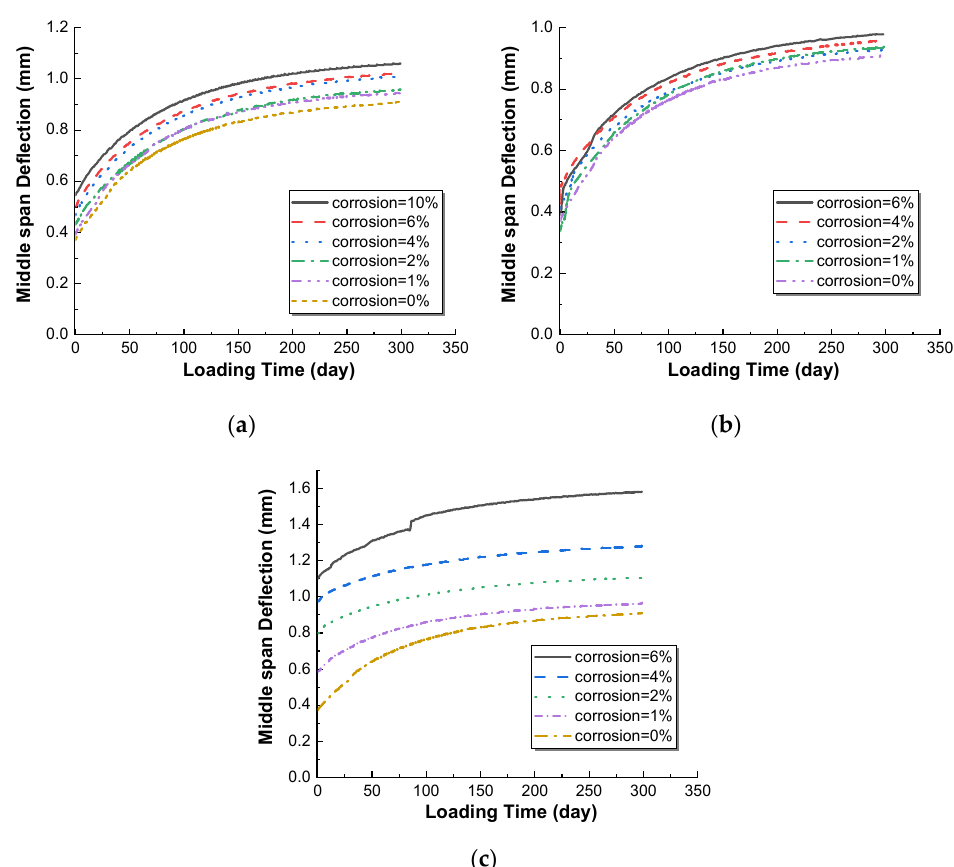
Figure 10. Deflection curves of RC beams with different corrosion patterns. ( a ) Corrosion of bottom bar; ( b ) Corrosion of top bar; ( c ) Corrosion of all bar.